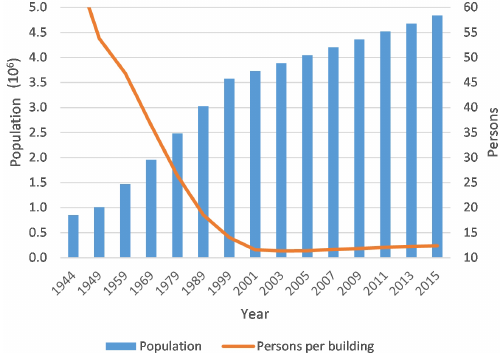
Figure 25. Population of the governorate of Alexandria (histogram) and density of persons per buildings (continuous line) from 1944 until